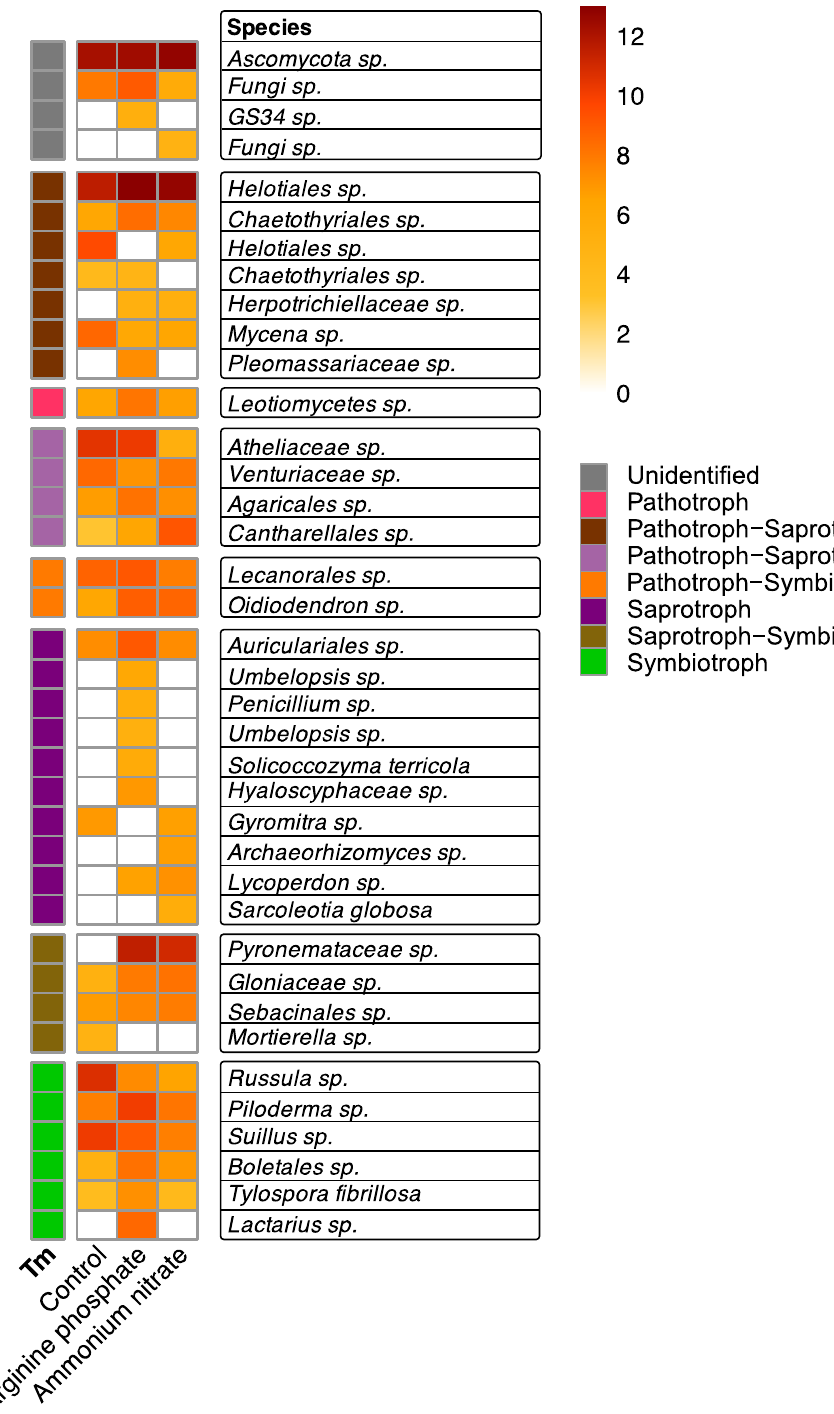
Figure 5. Heatmap depicting the most abundant amplicon sequencing variants (ASVs) with a cumulative presence of 50% of the total community on roots. Left column colored by trophic modes annotated on FUNGuild V1.1. Scale is log 10 of the sequencing reads.